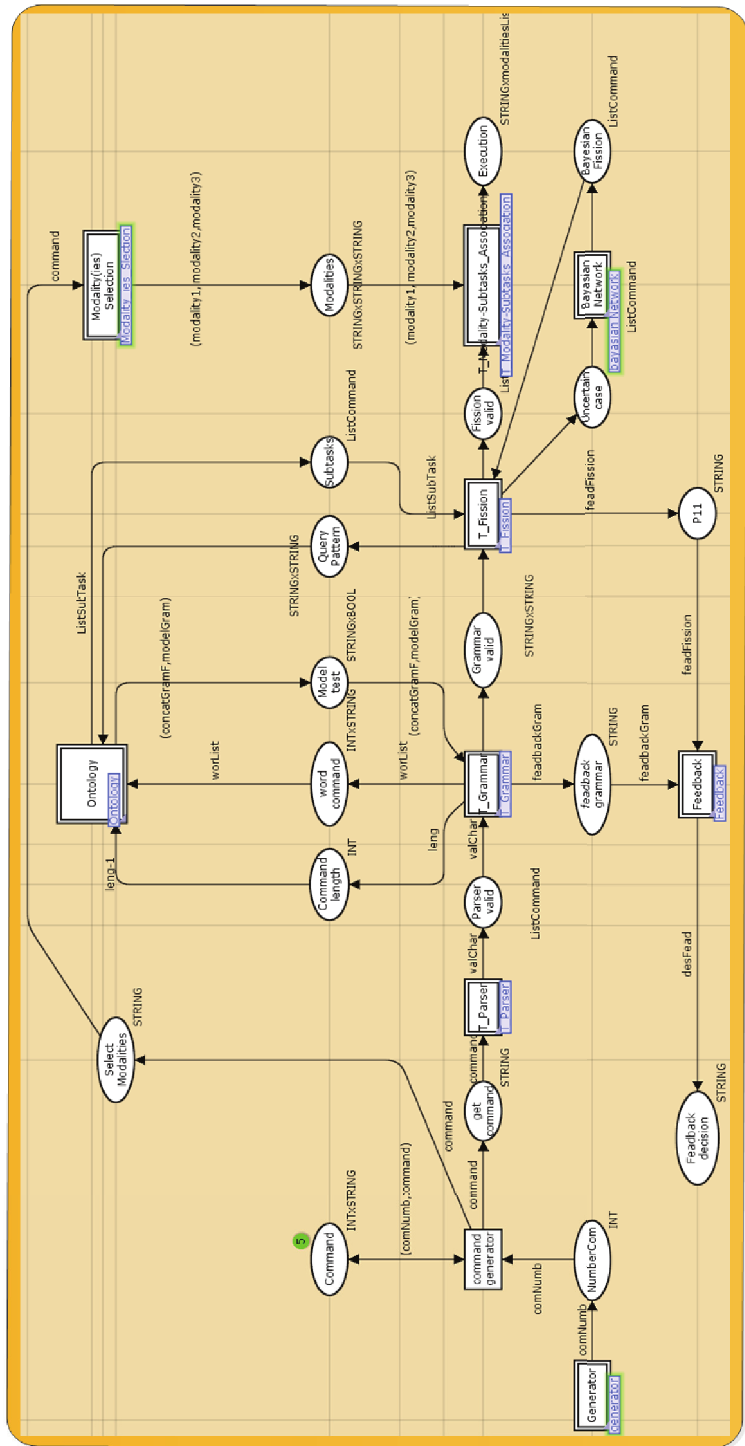
Fig. 12. General View of our